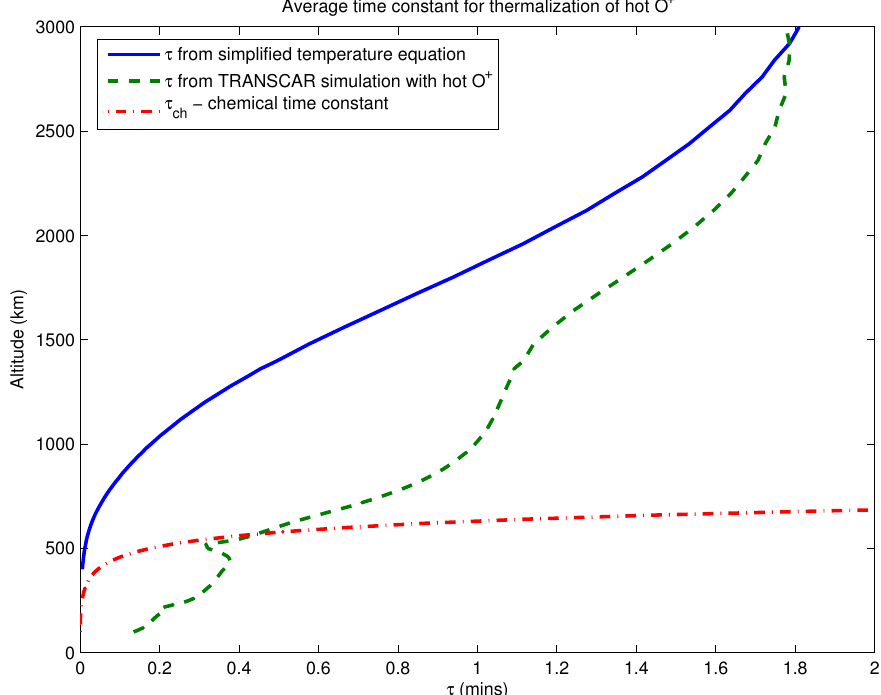
Fig. 1. Comparison of calculated and simulated thermalization time constants for hot O + . The chemical time constant (Eq. 1) is also shown for comparison